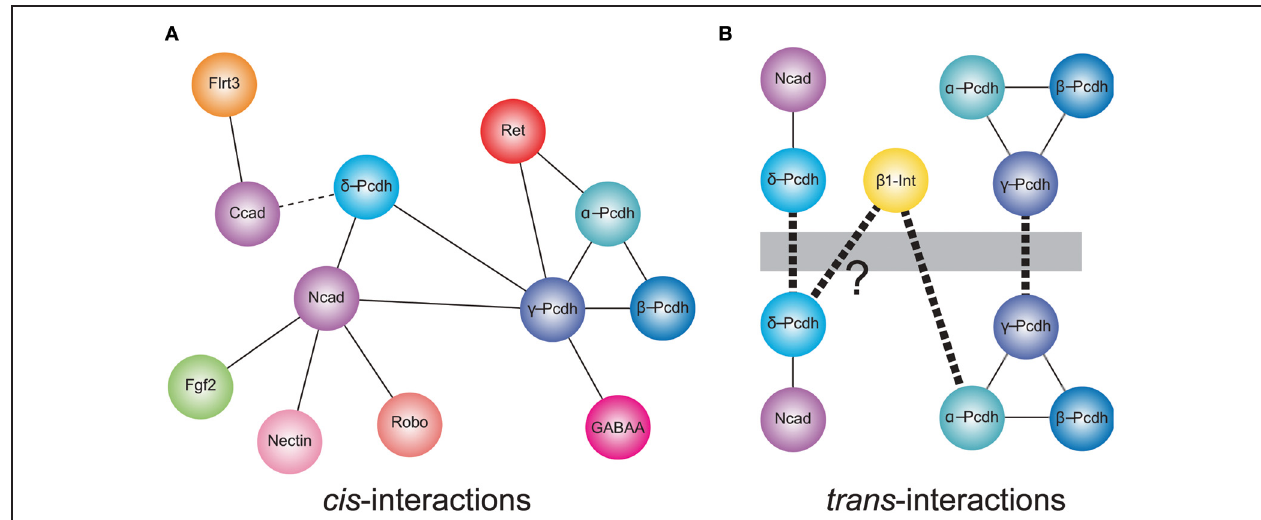
FIGURE 1 | Cis - and trans -interactions of the protocadherins. (A) Shown are cis-interactions at the membrane that have been identified for each of the protocadherin sub-families. Proteins containing cadherin repeats in their ectodomains (Ncad, α -, β -, γ - and δ -Pcdhs, and Ret) may mediate a core set of protein–protein interactions. These may be augmented by an expanded set of cis-interacting partners. In addition, δ -Pcdhs and γ -Pcdh isoforms can exist as homo- or hetero-oligomers, respectively. Lines represent direct interactions reported in the literature. The dashed line indicates that a direct interaction between C-cadherin and PAPC has not yet been demonstrated. (B) Members of each of δ -protocadherin and γ -protocadherin sub-families have been shown to mediate trans-homophilic interactions in vitro . These interactions